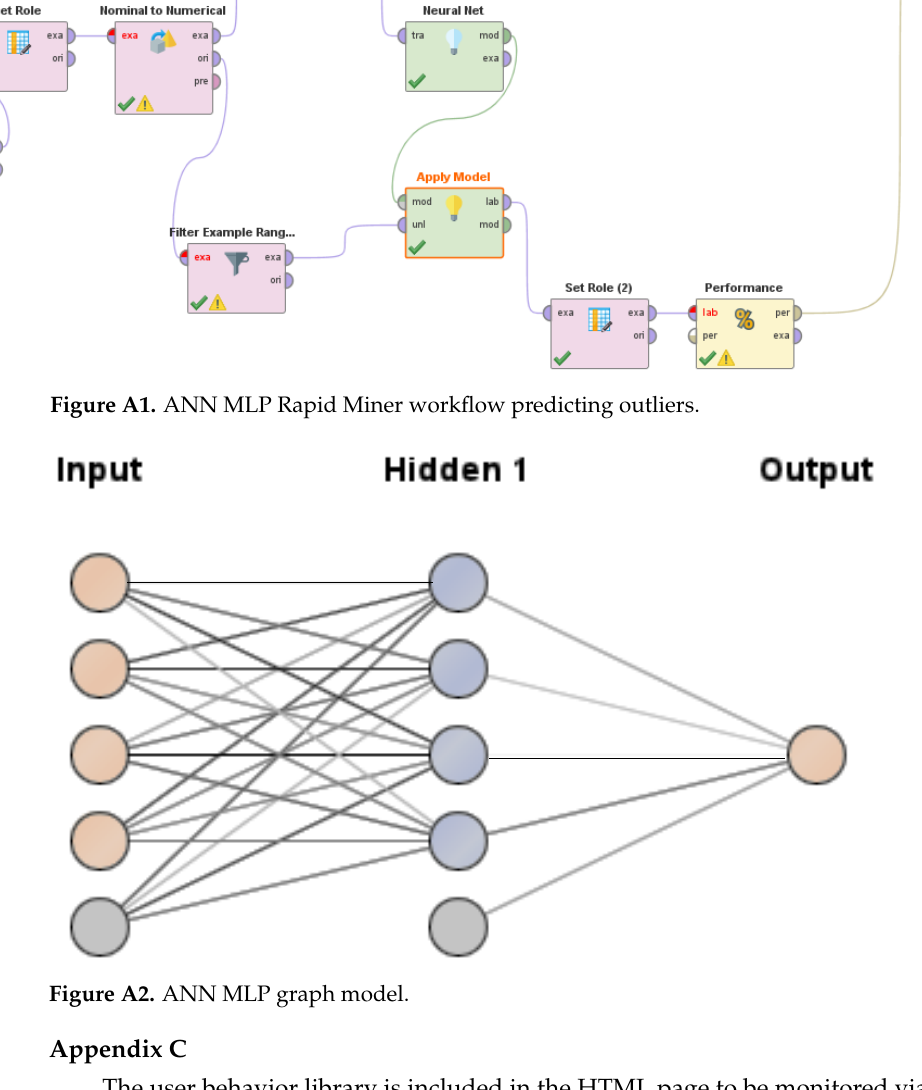
Figure A1. ANN MLP Rapid Miner workflow predicting outliers.